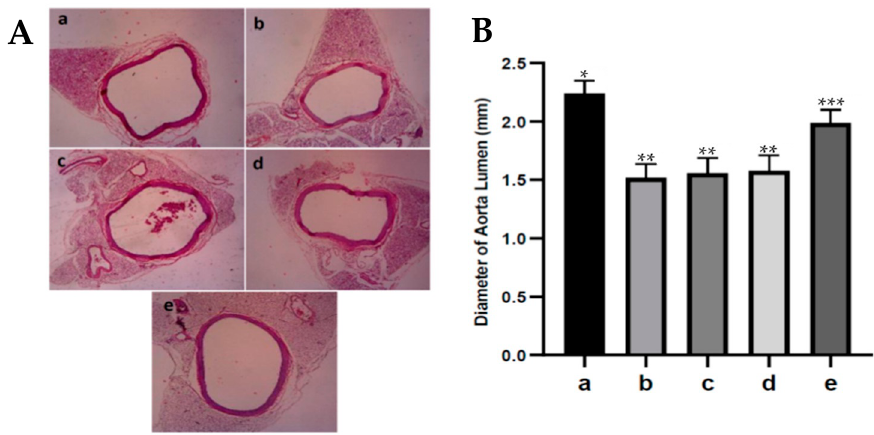
Figure 6. ( A ). The diameter of the aortic lumen from various treatments: control rats a; diabetic rats b; fucoidan nanoparticles at doses of 75 c, 150 d, and 300 mg/kg BW e. (400 × ). ( B ). The diameter Figure 6. A. The diameter of the aortic lumen from various treatments: control rats ( a ); diabetic rats of aortic lumens expressed in mm. *, **, *** The columns with different letters show significance ( b ); fucoidan nanoparticles at doses of 75 ( c ), 150 ( d ), and 300 mg/kg BW ( e ). (400×.). B. The diameter of aortic lumens expressed in mm. * - ***The columns with different letters show significance between between groups ( p < groups ( p < 0.05).